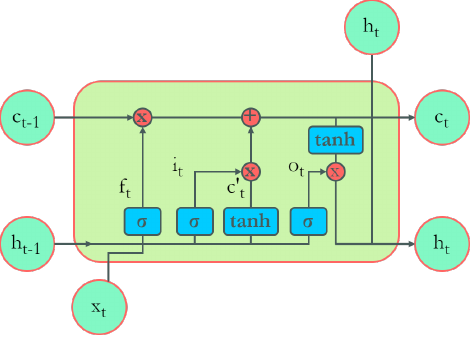
Figure 6. An LSTM cell